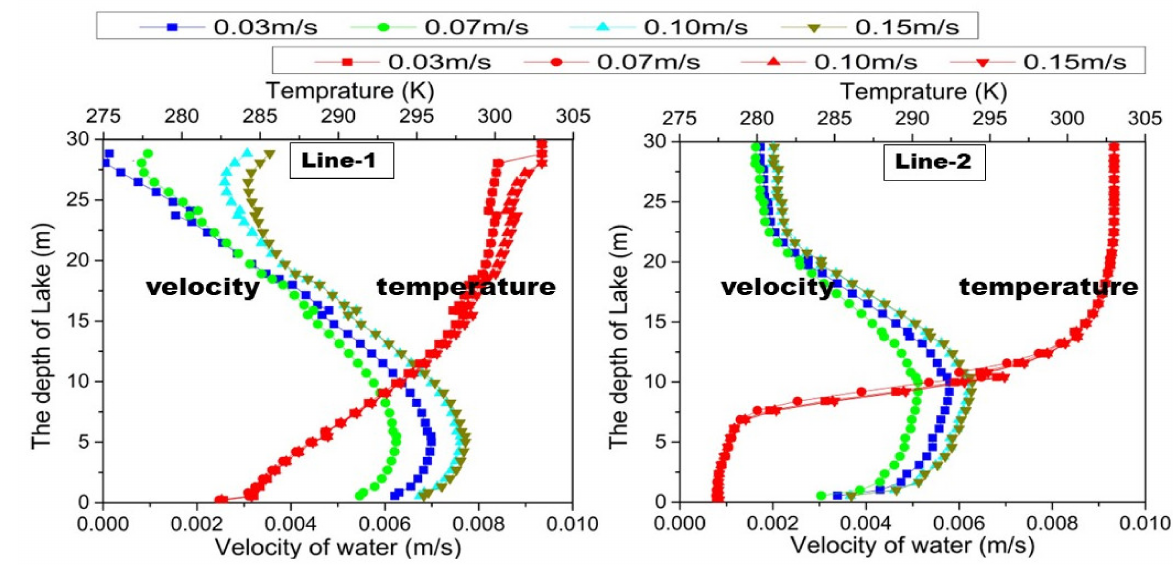
Figure 6. Vertical distribution of water temperature and velocity with different gas inlet velocities in Line 1 and Line 2 produced by